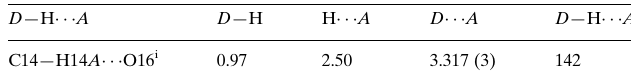
Hydrogen-bond geometry (A˚ , (cid:3)